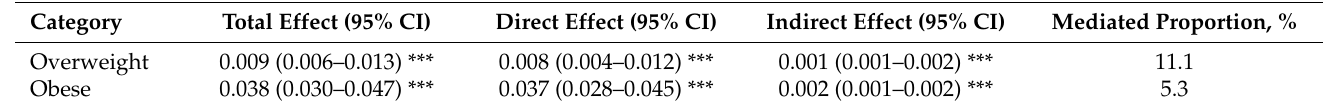
Table 4. Mediation effects of high mTG levels in combination with GDM on the relationship of overweight/obesity with macrosomia.